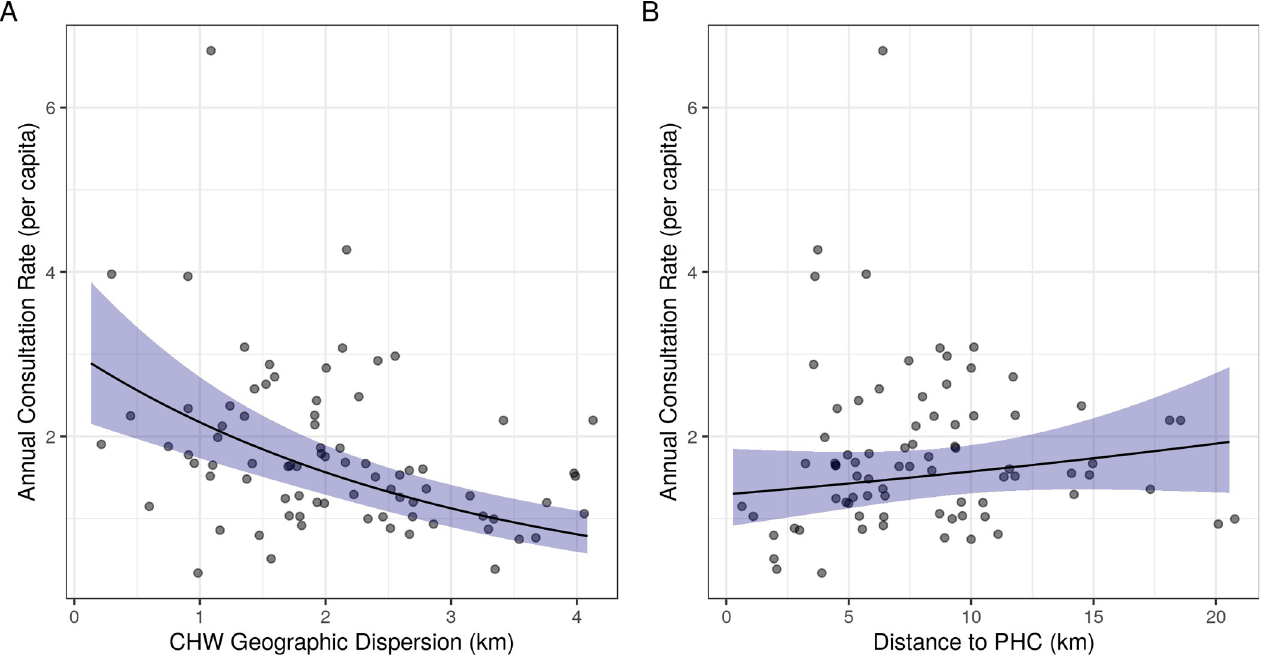
Fig 2. CHW consultation rates for children under 5 years decrease with increasing CHW geographic dispersion and increase with increasing distance to the nearest PHC. Lines represent the estimated marginal mean effects of each variable with 95% confidence intervals from the fitted model, holding all other variables constant at their mean value. Points represent the mean annual CHW consultation rate for each fokontany from May 2018—May 2021. CHW: community health worker, PHC: primary health center.